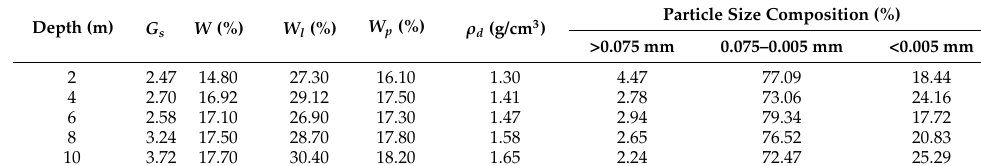
Figure 1. ( a ) The loess distribution map of China and ( b ) the geological map of the loess plateau. ( c ) Sample preparation process and pictures of the test instrument.